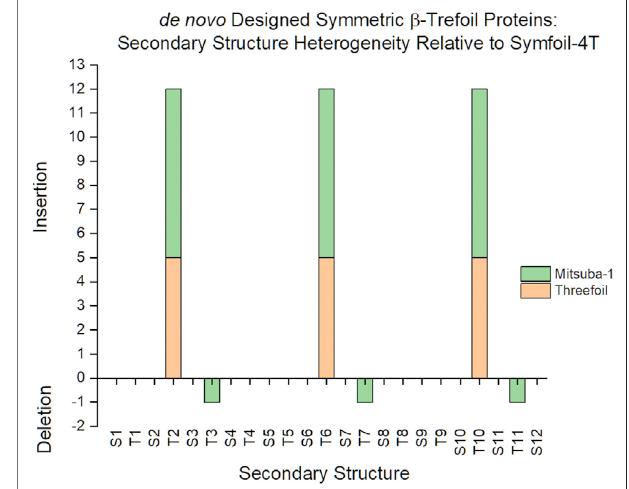
FIGURE 2 | A comparison of secondary structure insertions/deletions for three symmetric designed β -trefoil proteins. The Symfoil, Threefoil, and Mitsuba-1 proteins are three independently de novo designed, purely- symmetric β -trefoilproteins.Themostcompact ofthesethreeisSymfoil, primarily due to ligand-binding turns T2, T6, and T10, engineered into both Threefoil and